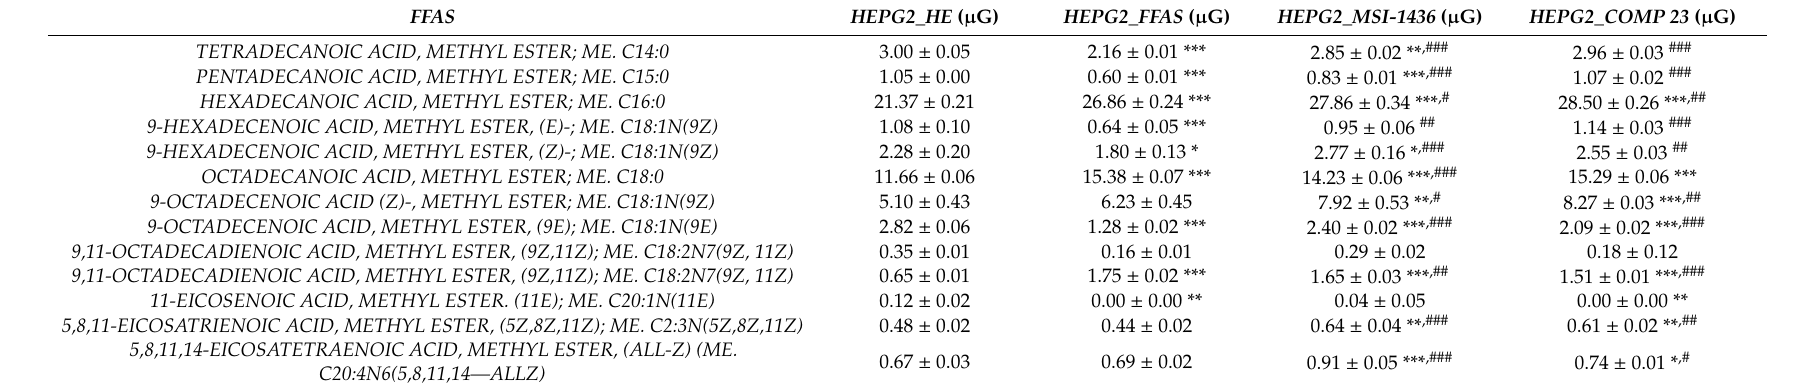
Table 2. Fatty Acid Composition of the FFA Lipid Class in HepG2 treated and untreated